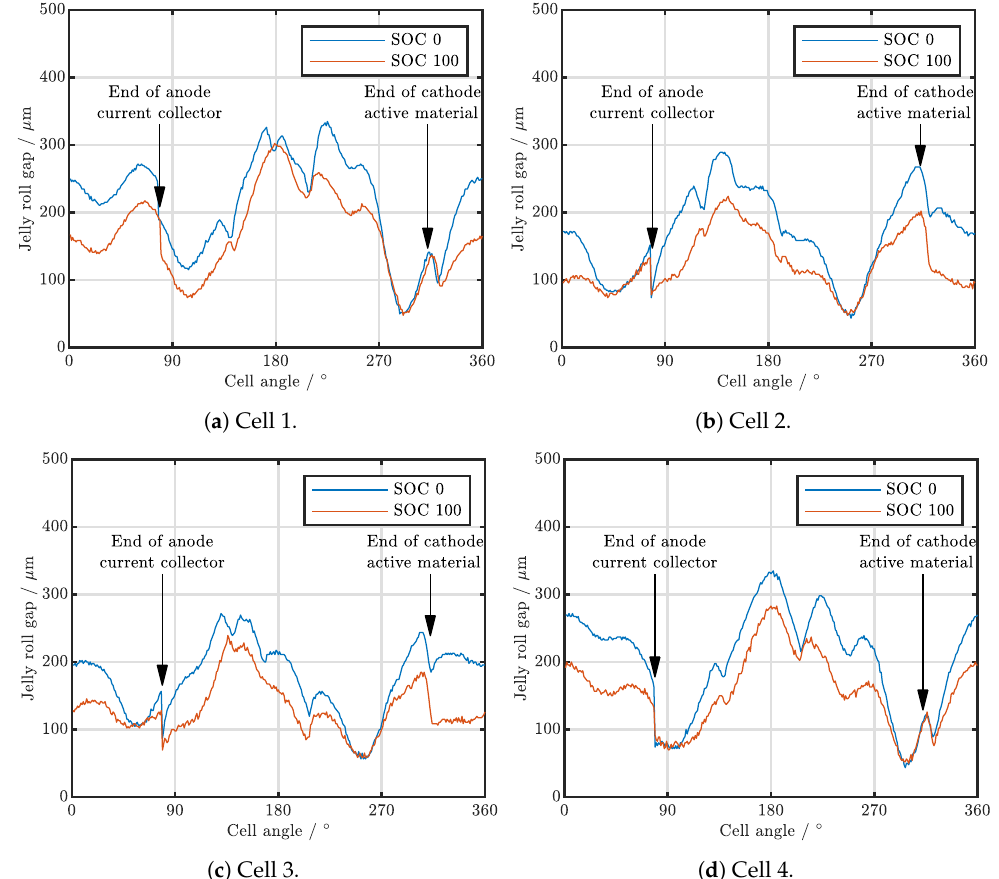
Figure 3. Jelly-roll gaps for four new Samsung INR18650-25RM cells at 0% and 100% SOC in the middle of the